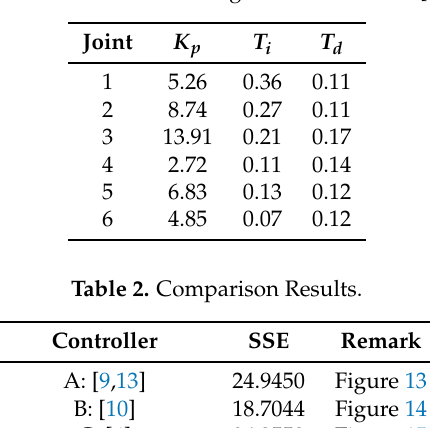
Figure 15. Tracking performance: Controller C. Table 1. Parameter settings for Controller C [6].